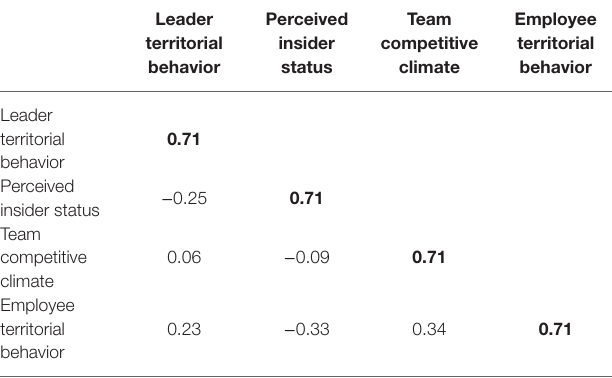
TABLE 4 | Correlation and the square roots of